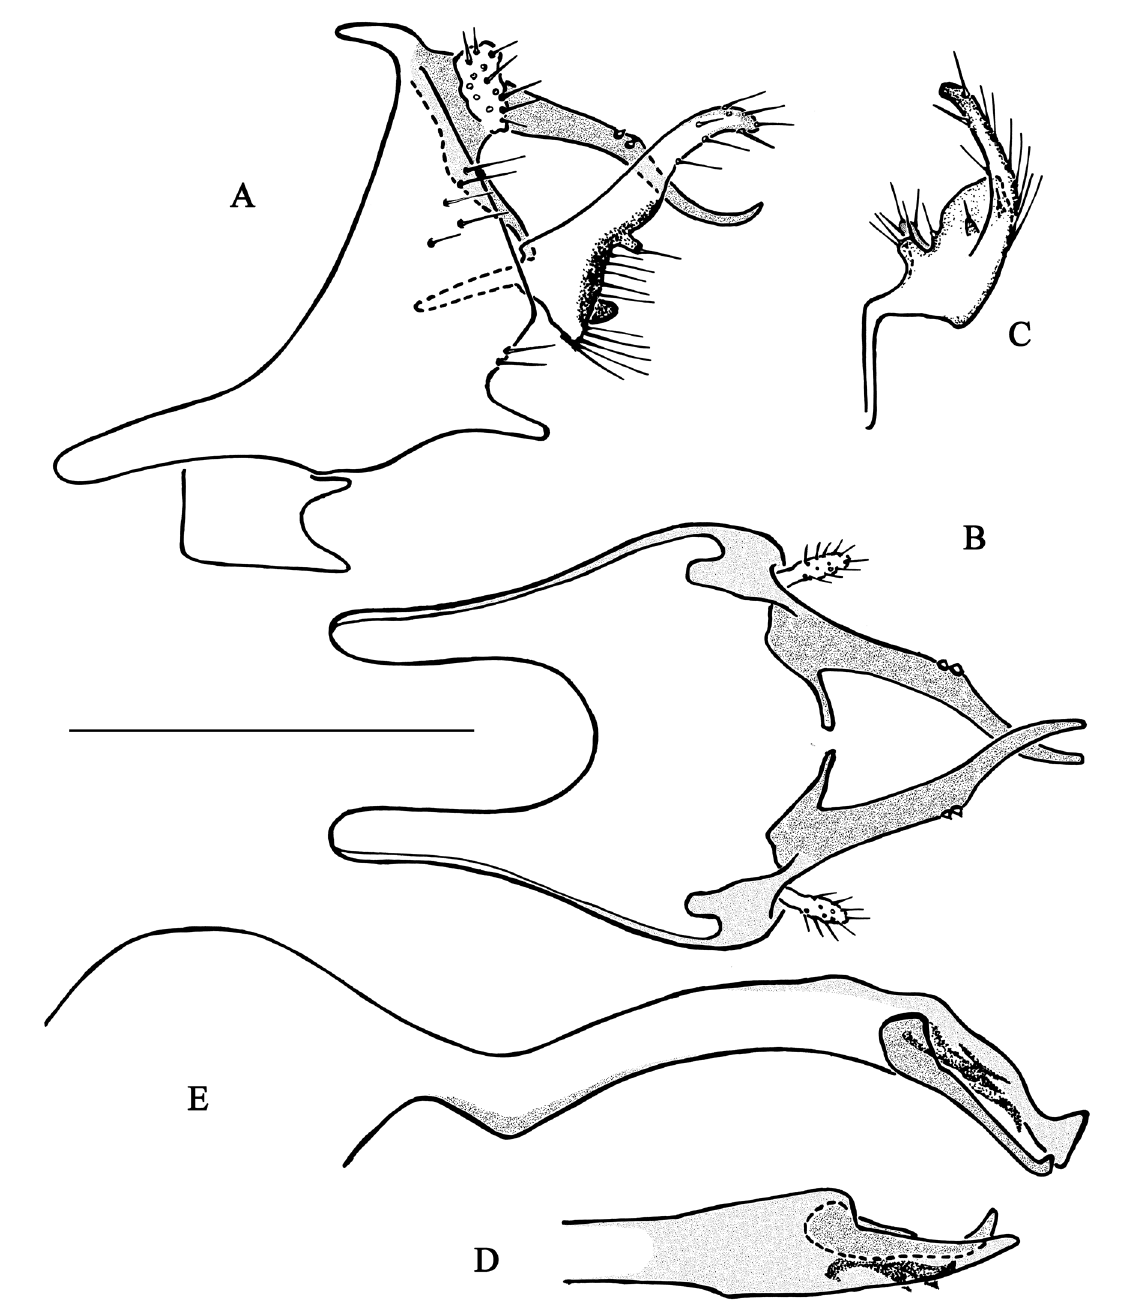
Fig. 12. Chimarra moramanga sp. nov. A–B . Abdominal segments IX and X. A . Lateral view. B . Dorsal view. C . Inferior appendage, dorsal view. D–E . Phallic apparatus. D . Apex, dorsal view. E . Lateral view. Scale bar = 0.5